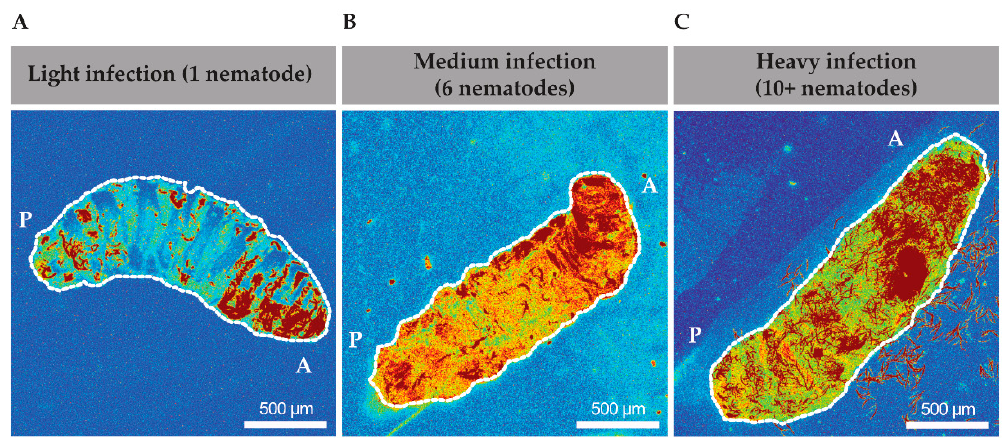
Figure 2. Heat maps of EPN Heterorhabditis bacteriophora movement inside of the host, Drosophila melanogaster . Time-lapse images were processed into maximum intensity projections of individual time points which were then combined throughout acquisition. Representative images are taken for low (1–4 EPNs, A ), medium (5–10 EPNs, B ), and high (10 + EPNs, C ). “A” marks the anterior side of each larva while “P” marks the posterior side of each larva. Scale bar—500 μ m.